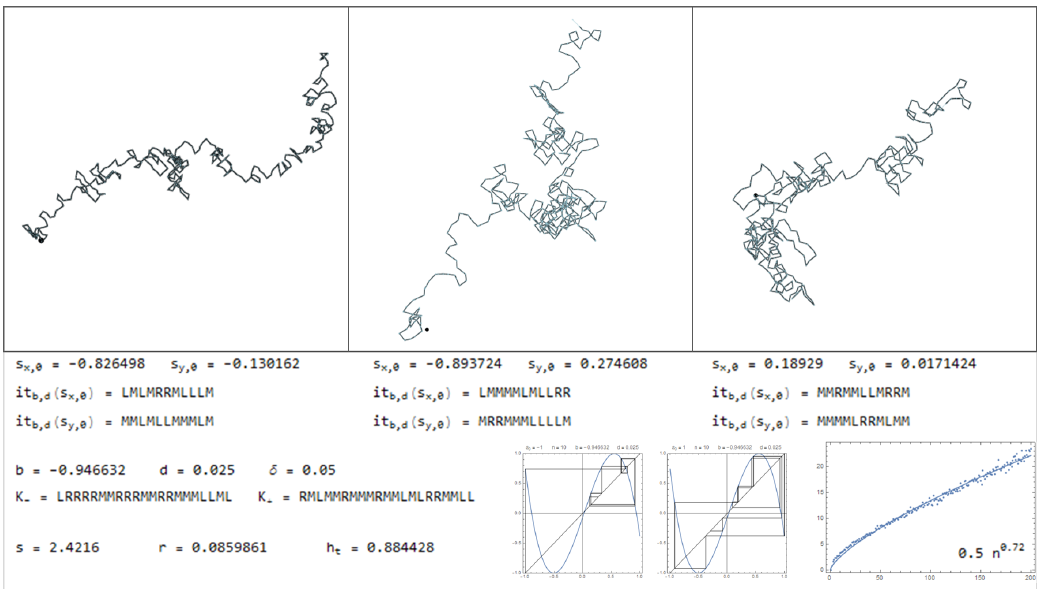
Figure 26. Trajectories produced with b = − 0.946632 and d = 0.025.